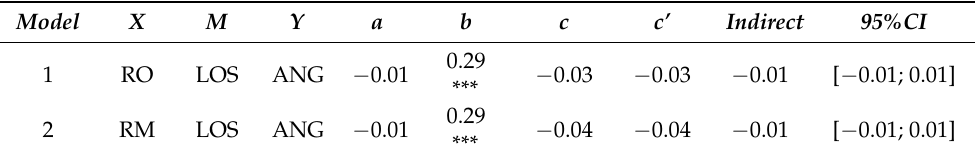
Table 5. Results of the performed mediation